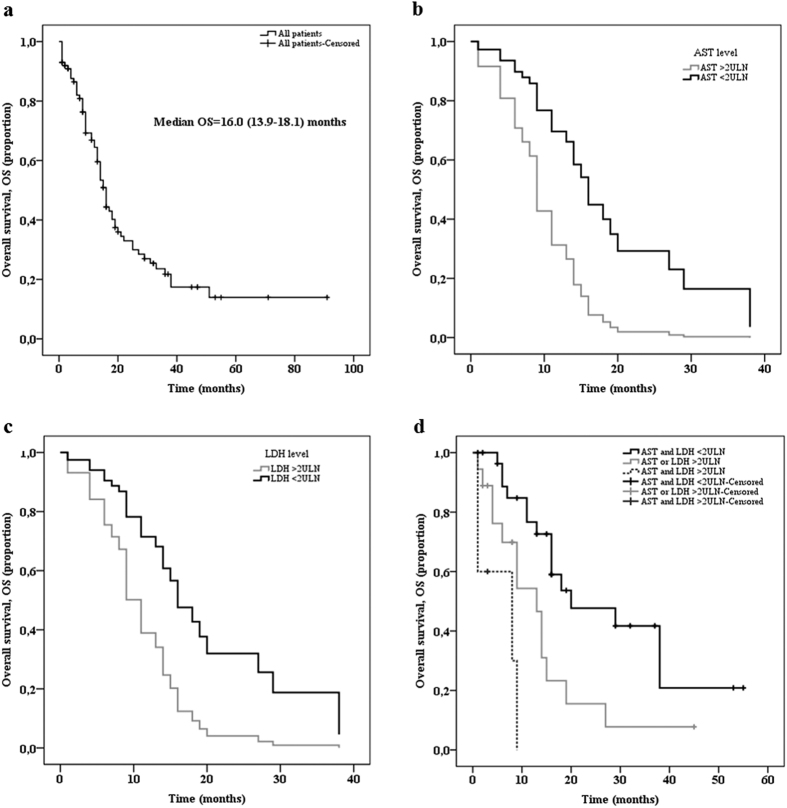
Overall survival (OS) among the population with GEP-NEC (a), and according to serum AST level (b), serum LDH level (c), and combining AST and LDH (d).